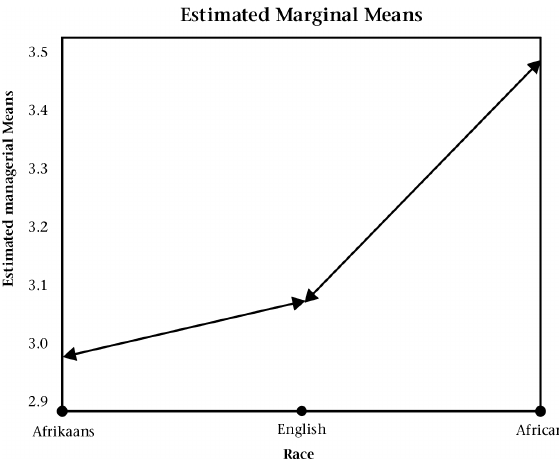
Figure 7:Biographical variable: Home language as